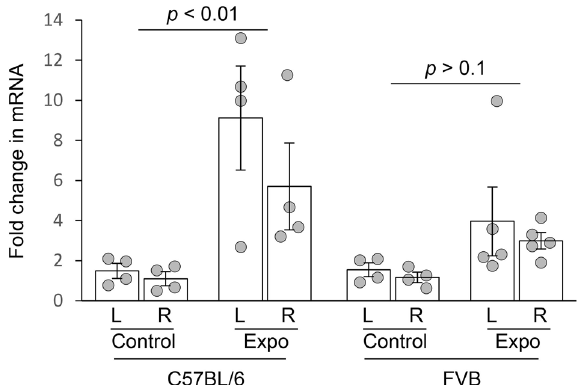
Figure 2. Strain differences in noise-induced increase of TNF-α expression. TNF mRNA level significantly increased in C57BL/6 but not FVB mice 10 days after noise